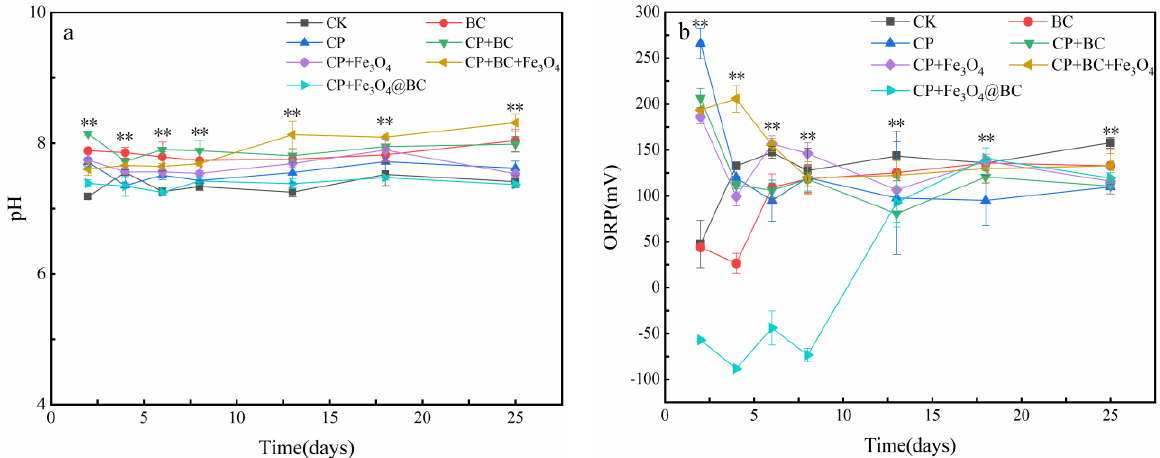
Figure 3. The variation of pH and ORP in overlying water during the experimental study: ( a ) pH. ( b ) ORP; ** indicates a significant effect at the 0.01 probability level between the control and different treatments.